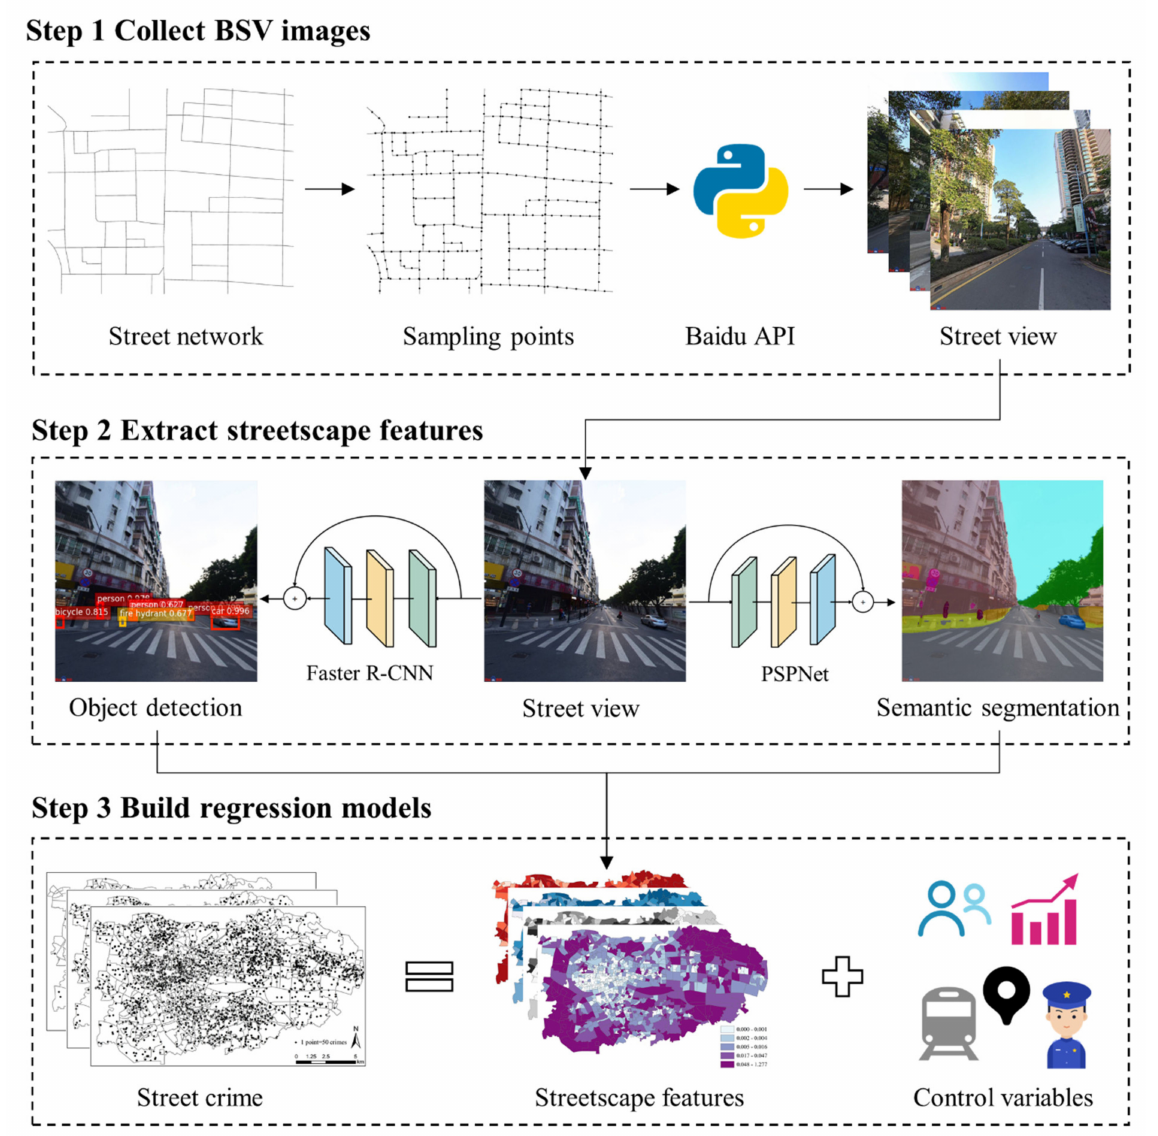
Figure 5. Workflow of this